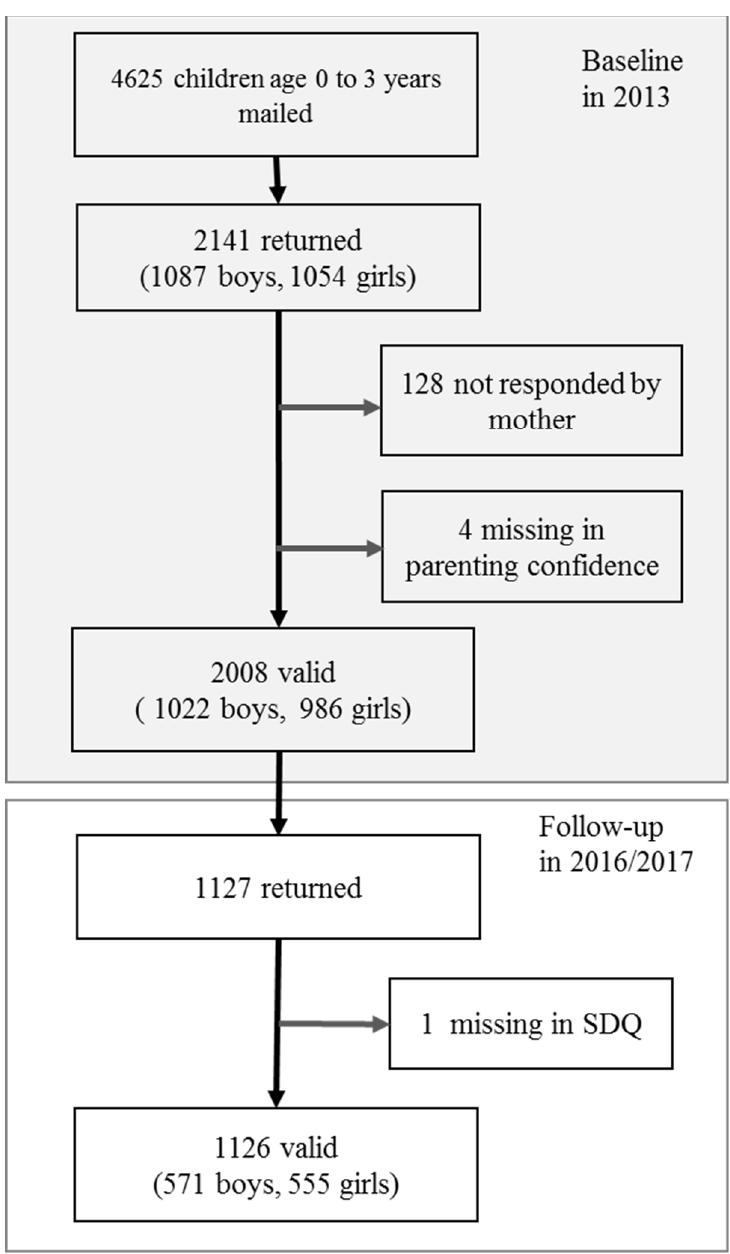
Figure 1. Flow chart of study participants.